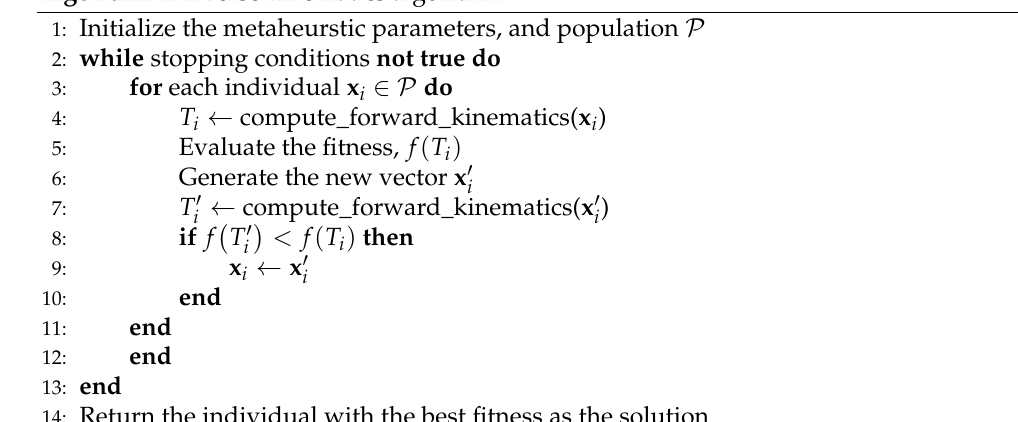
Algorithm 2 Inverse kinematics algorithm.